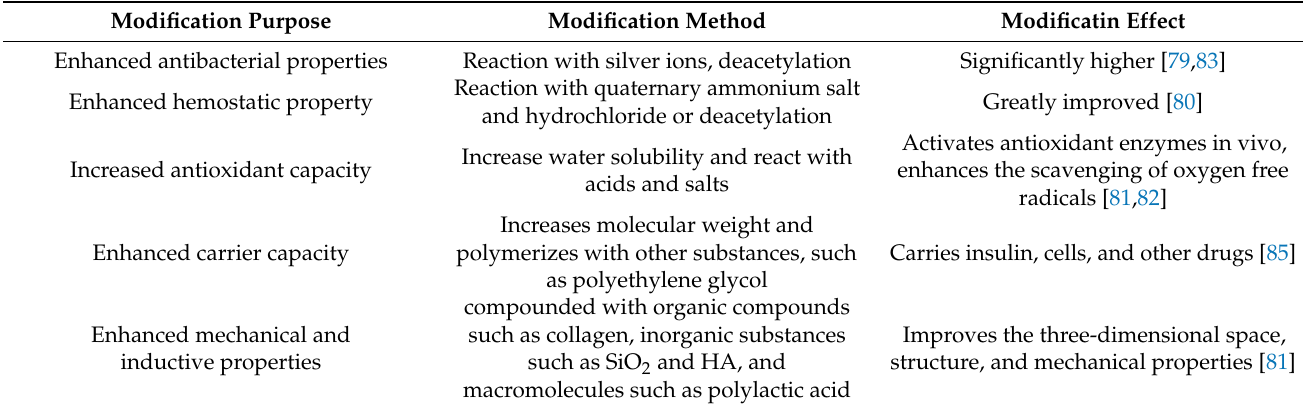
Table 3. Modification purpose, modification method, and modification effect of chitosan.